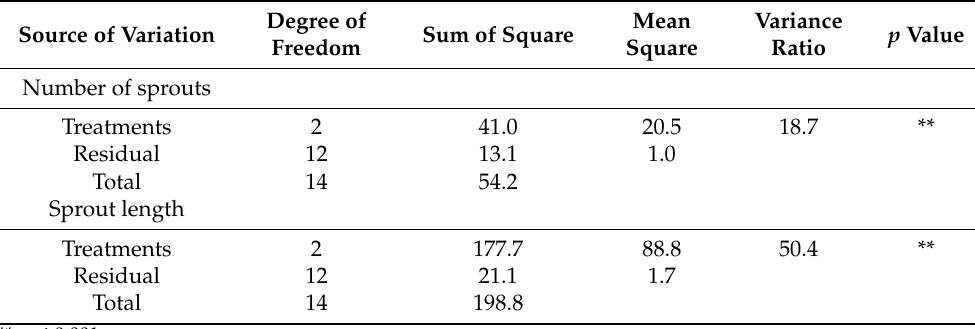
Table 3. Mean number and length of sprouts of Moringa oleifera trees in three growing areas in South Africa during the 2020 growing season. Location Number of